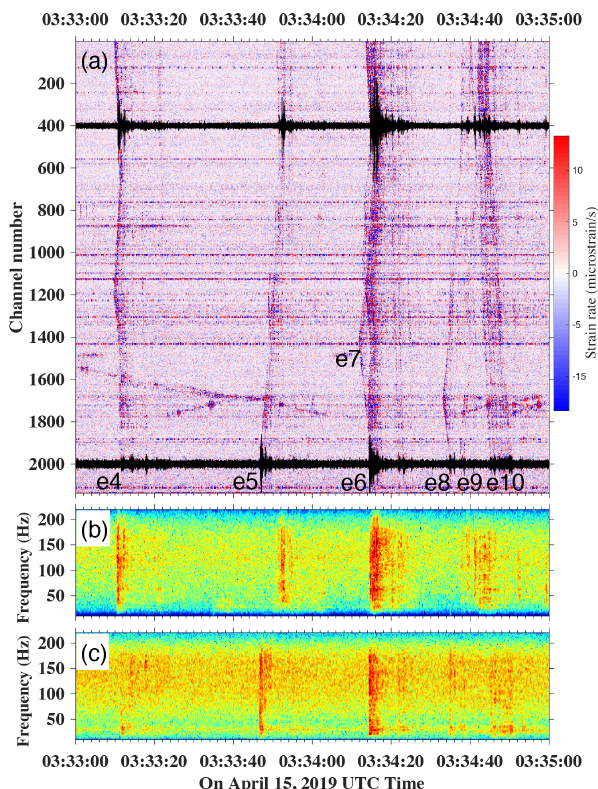
Figure 7. DAS recordings of (a) thunderquake events on 15 April 2019. Two traces (channels 400 and 2000) are overlaid. Panels (b) and (c) show DAS spectrograms (0–40dB) computed for channel 400 and channel 2000, respectively.